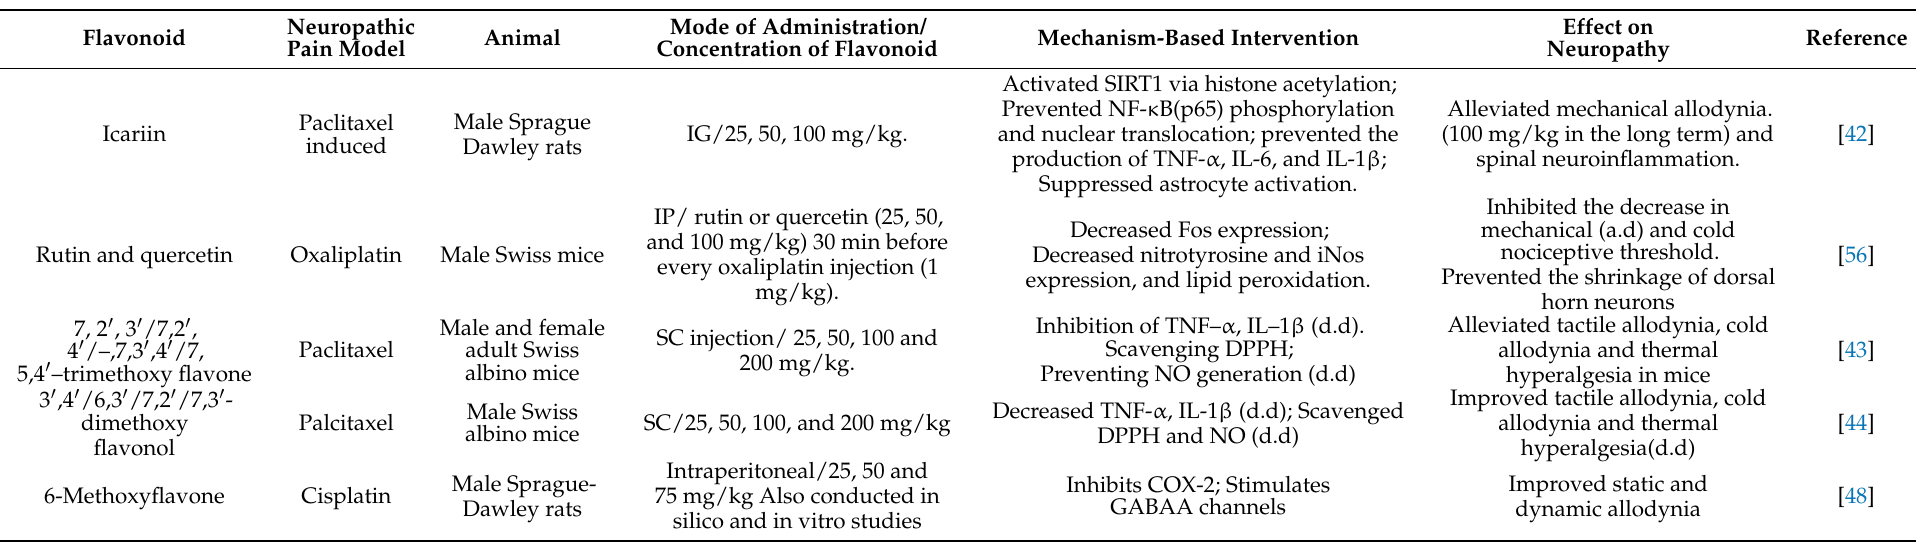
Table 4. Previous studies investigating the effects of flavonoids on CIPN models at the